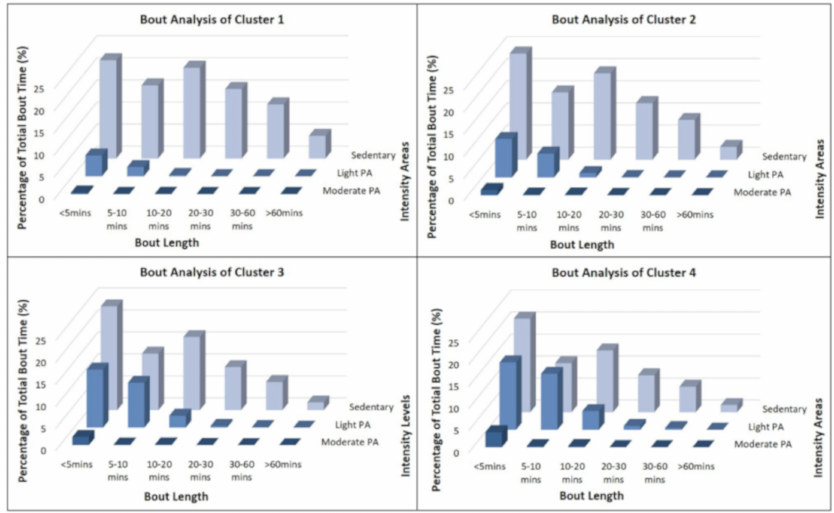
Figure 3. Physical activity and sedentary bout analysis for all four